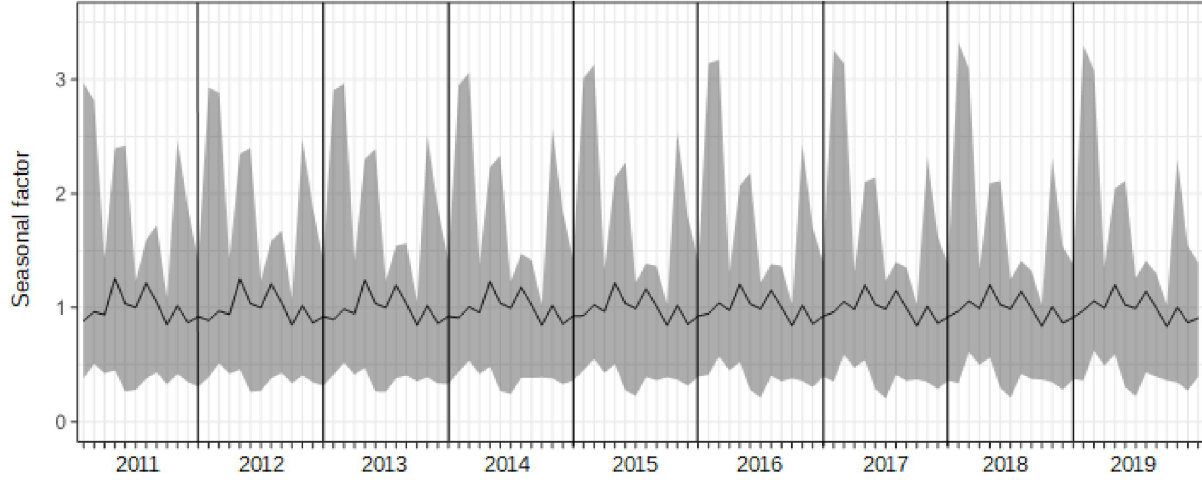
Fig 8. Range between maximum and minimum of seasonal factors among prefectures in inbound guests for